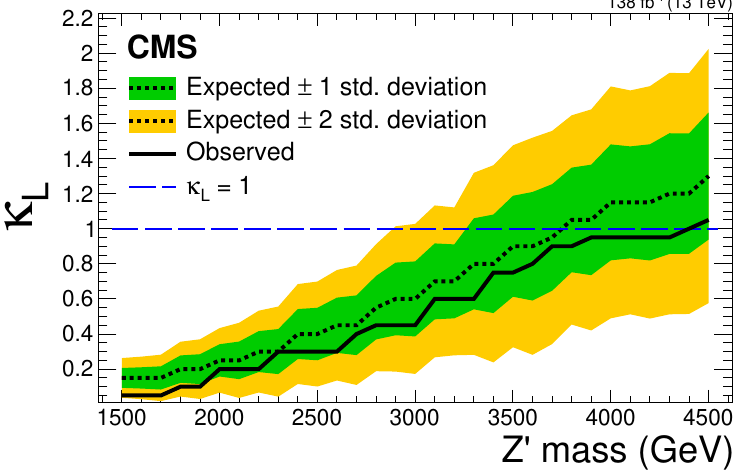
for a Z 0 in the sequential L = 1 which corresponds L